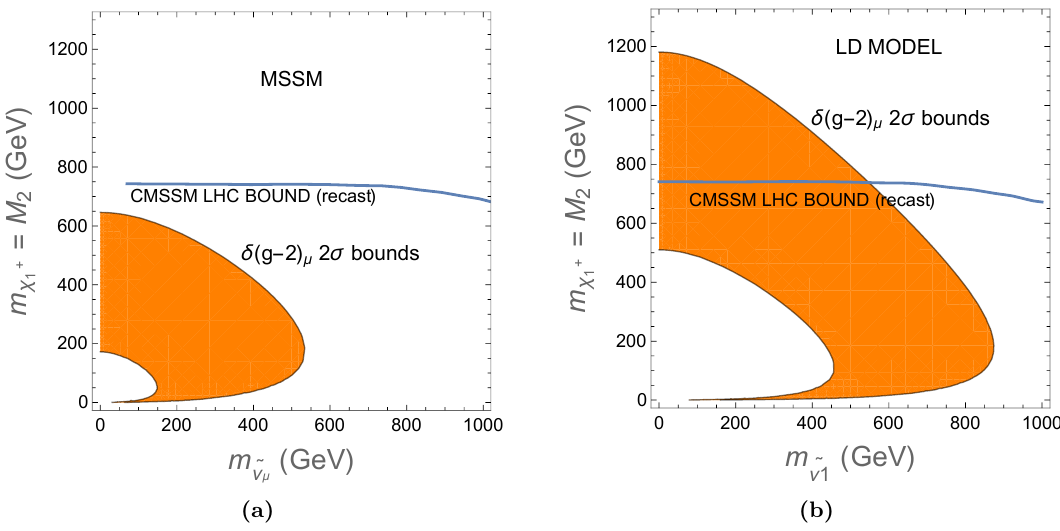
Figure 7. (a) We show in orange the 2 (cid:27) region of (cid:14) ( g of the MSSM. We assume tan (cid:12) = 30 and (cid:22) = 1200 GeV. The LHC lower bound from squark and gluino searches [5] projected to the ( m ~ (cid:23) applied is shown as a solid gray line. (b) The 2 (cid:27) region of (cid:14) ( g plane. We assume M L = 600 GeV, (cid:21) L = 0 : 25, f M L = 10 GeV, e m 2 with all parameters de(cid:12)ned at the SUSY